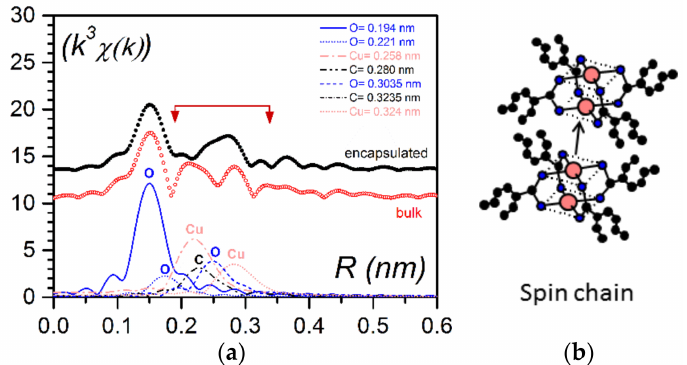
Figure 7. ( a ) Pseudo-radial distribution functioned in the vicinity of copper atoms as obtained by EXAFS; for the encapsulated bicopper complex, for the bulk state (note the systematic difference (cid:35) of approximately 0.05 nm in EXAFS with the actual distances). The difference between the curves occurred in the domain involving Cu–Cu distances ( b ) a spin chain where the Cu–Cu interaction between adjacent molecules occurred in lieu of the Cu–O interaction seen in the bulk state [20,22].